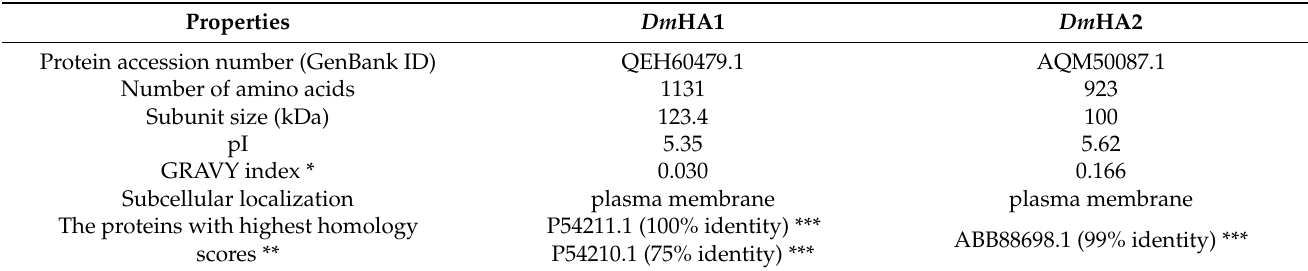
Table 1. Molecular properties of Dm HA1 and Dm HA2 based on their deduced amino acid sequences (computed